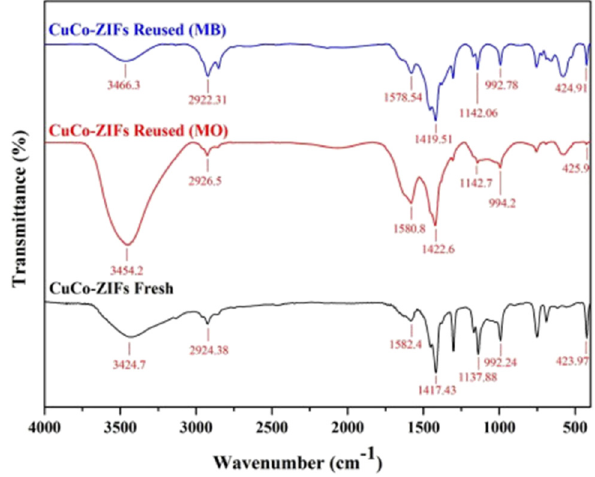
Figure 12: FT - IR spectrum of reused - CuCo - ZIFs, in comparison to fresh